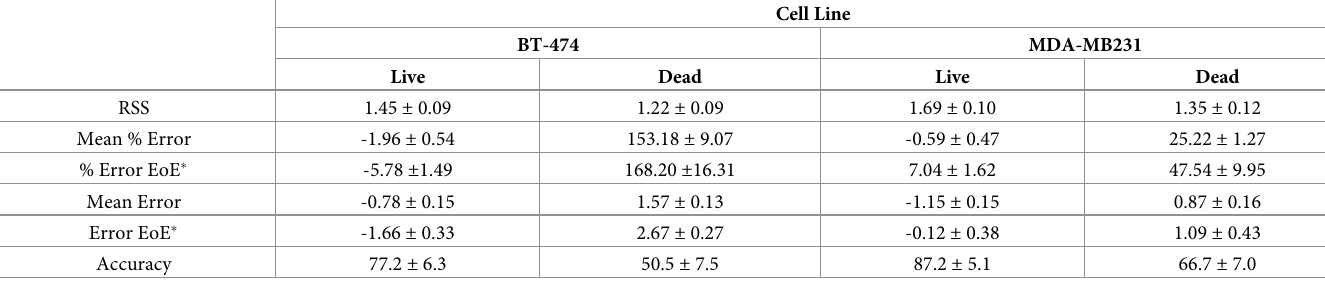
For the BT-474 cells, we reported the model performance during training (Table 5). The average mean percent error across all timepoints, and the average percent error at the end of experiment were < 1% for live cells. Although the average mean percent error across all time- points, and the average percent error at the end of experiment were > 45% for dead cells, the average mean error across all timepoints and average error at the end of experiment were < 1% for both live and dead cells. The average uncertainty across 50 training sets for live and dead cells were 6.88 ± 0.09% and 30.83 ± 0.15%, respectively. For the BT-474 cells, the parameters k and α in Eq [7] were estimated as described in bys , 0 section 2.7 and a specific parameter surface of k was determined. The uncertainty calculated bys from fitting the data of the training set to the model was used to estimate the confidence inter- val of the initial confluence from the validation set. The initial conditions (i.e., initial glucose level and confluence) from the validation set were used with Eq [7] to identify the value of k bys to be used, in conjunction with the three global parameters ( k , v , and k and their respective p d confidence intervals) in Eqs [1]–[5] to run the forward model. This process was repeated 50 times to obtain an average RSS, average mean percent error, average percent error at the end of experiment, average mean error, average error at the end of experiment, and accuracy (Table 6). The accuracy was defined as the percent of data points falling within the 95% confi- dence interval of the predicted values. The average RSS was 1.45 ± 0.09 and 1.22 ± 0.09 for live and dead cells, respectively, while the accuracy was 77.2 ± 6.3% and 50.5 ± 7.5% for live and dead cells, respectively. The average mean percent error across all timepoints and the average percent error at the end of experiment were both < 2% for live cells. Although the average mean percent error across all timepoints and average percent error at the end of the Table 6. Evaluation of prediction across 50 rounds of training and